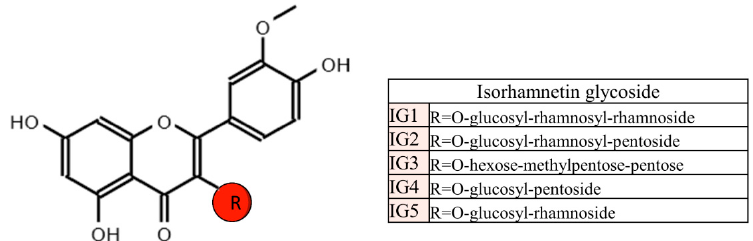
Figure 4. Isorhamnetin glycosides found in Opuntia-ficus indica.